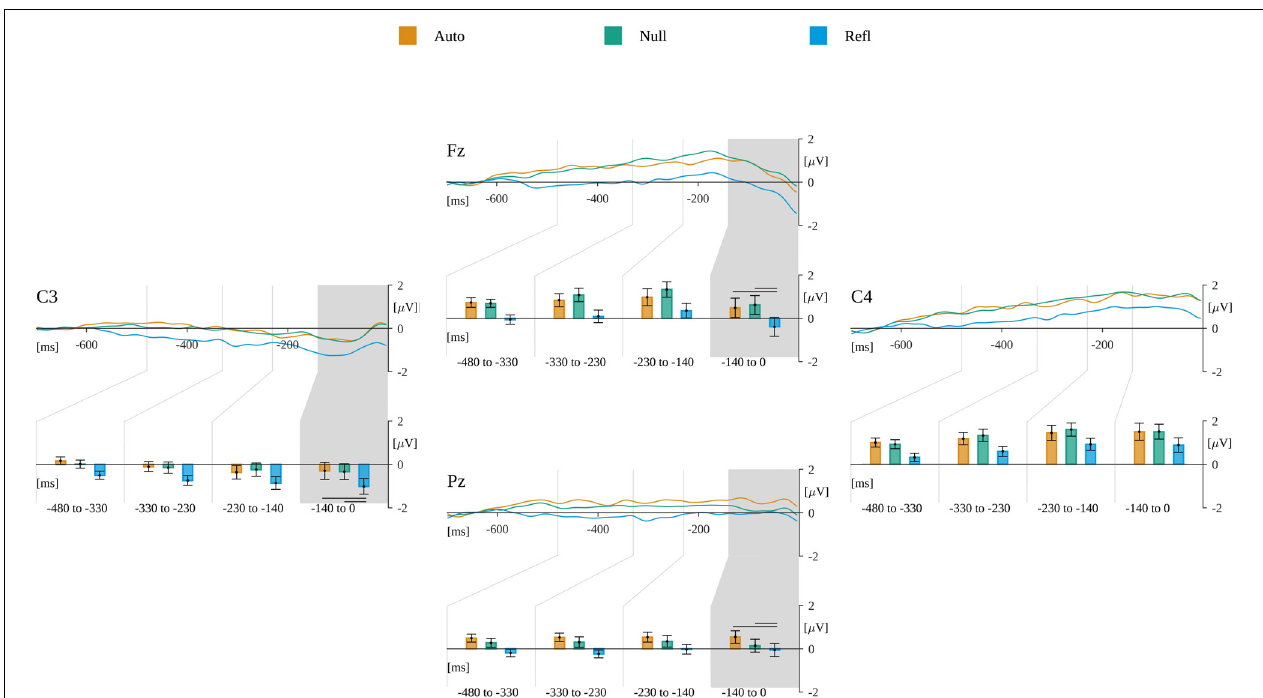
FIGURE 10 | Effects of origin in subsequent time windows during decision-making. For each ROI the time course of ERP for each level of origin is plotted. Gray backgrounds mark time windows with statistically significant origin ∗ ROI interaction. Beneath, the bars present the amplitude averaged within each time window. Horizontal lines indicate levels of origin that differ significantly from each